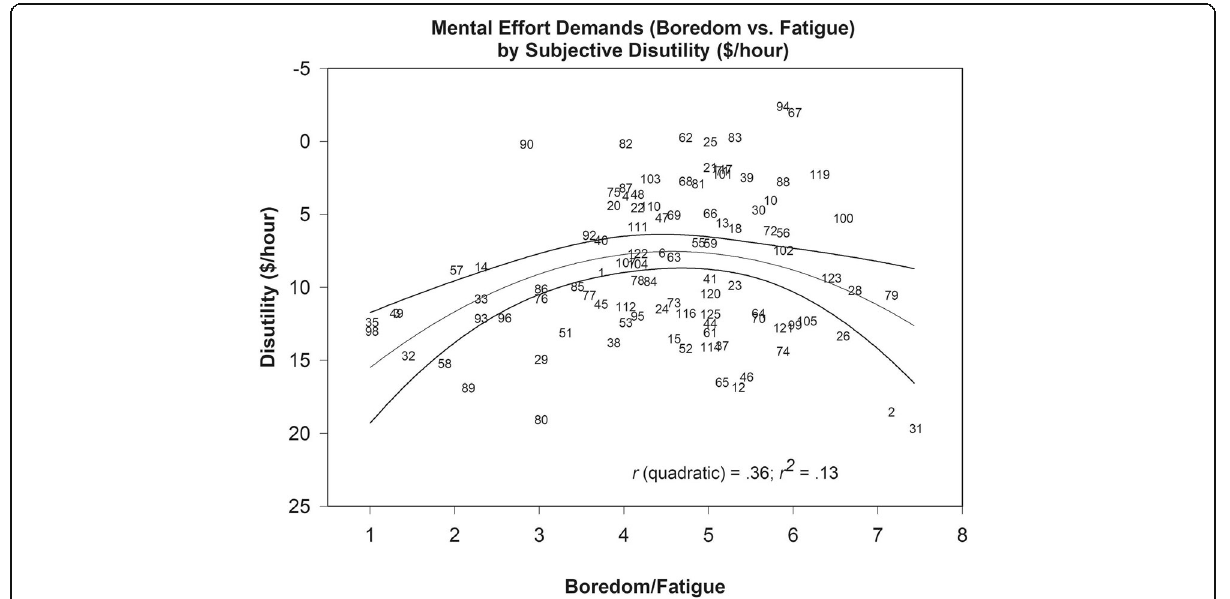
Fig. 1 Rated task mental effort demands (boredom vs. fatigue) plotted against mean subjective disutility ($/hour) values. Quadratic regression shown with 95% confidence intervals as solid lines . Numbers indicate the task designation in Table 1. Disutility ratings N = 77, Boredom vs. Fatigue N =